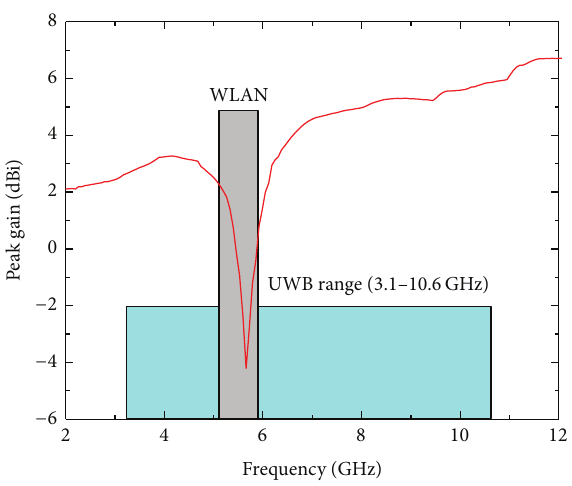
Figure 19: Simulated peak gain of the final MIMO antenna. while a gain drop of 4.5 dB is observed at the WLAN-notched band.